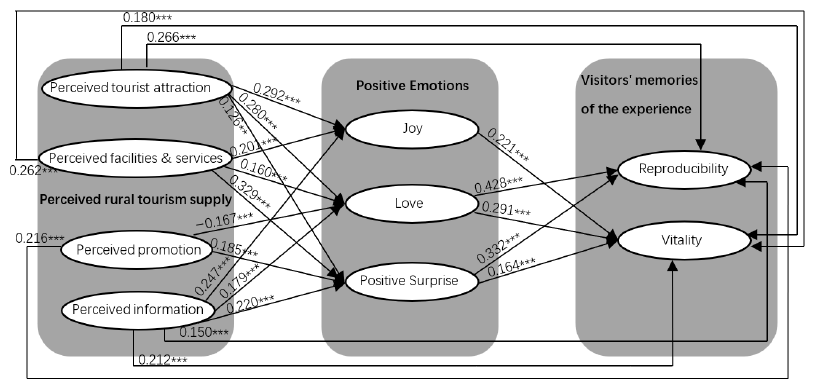
Figure 2. The action mechanism of antecedent variables of rural tourism experience memory. *** p <